Question: What form of chart is displayed?
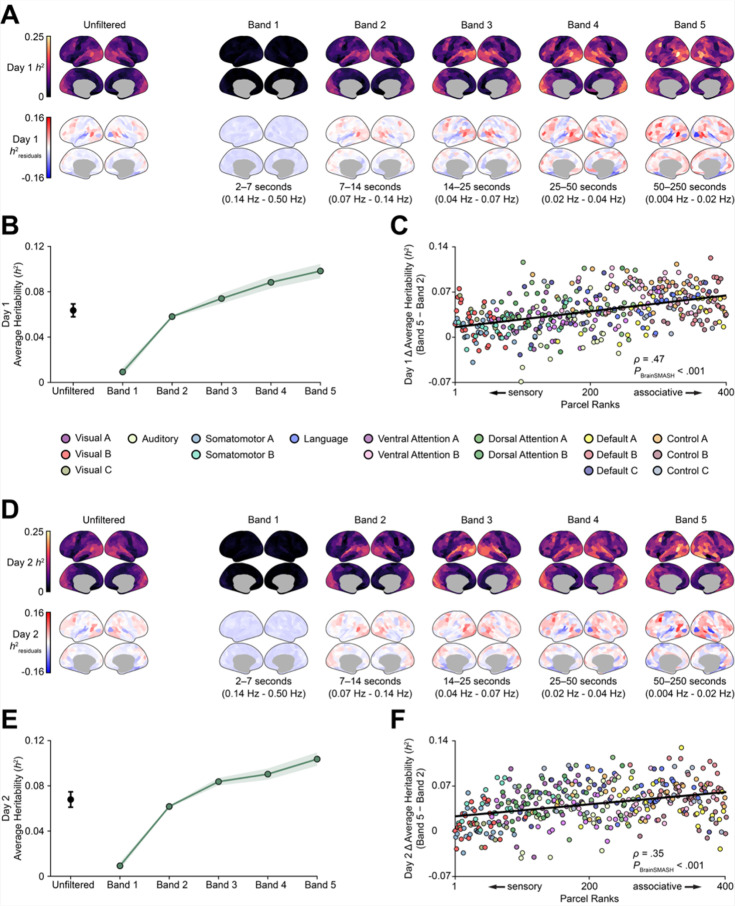
Answer: scatter